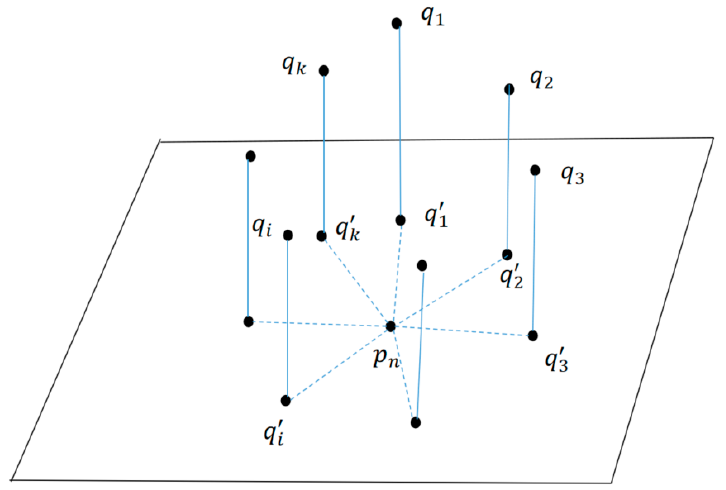
Figure 3. k nearest neighbor points( Q ) projected on the perpendicular plane of normal vector ( L ).